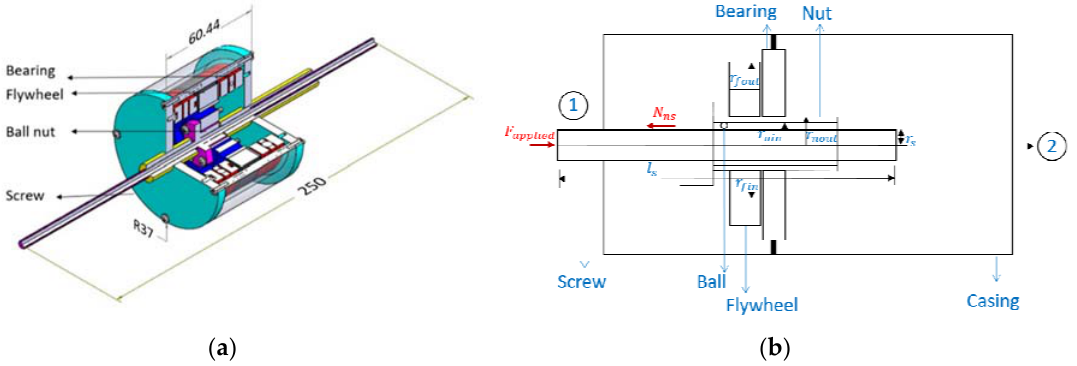
Figure 1. ( a ) CAD model of the ball-screw inerter, and ( b ) line diagram of the ball-screw inerter showing forces and geometric parameters. All of the dimensions shown are in mm.